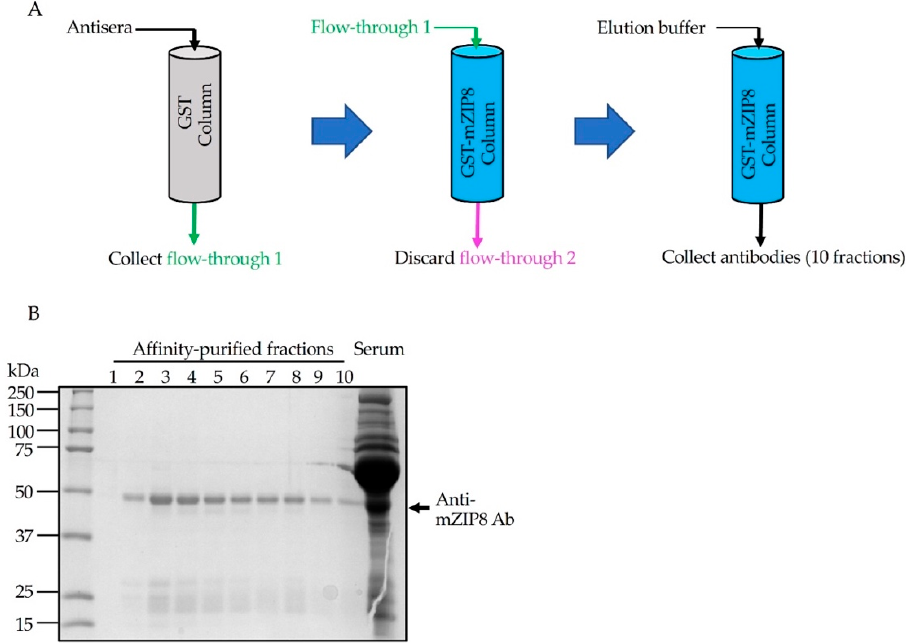
Figure 4. Purification of anti-mZIP8 antibody. ( A ) A schematic illustration of the affinity purification procedure. Rabbit antisera were diluted in binding buffer. The diluted sera were first applied to GST-linked sepharose column (GST column) three times to deplete anti-GST antibodies. The flow-through (flow-through 1) was then applied to the GST–NT-mZIP8-linked sepharose column (GST–mZIP8 column) to allow the binding of anti-mZIP8 antibody. The flow-through (flow-through 2) was discarded and the elution buffer was applied to elute antibodies (10 sequential fractions were collected, 1 mL/fraction). ( B ) Coomassie staining of SDS-PAGE gel loaded with different fractions of anti-mZIP8 antibodies, together with the original antiserum. The pooled antibodies from fractions 2, 3, and 4 were further used for antibody validation experiments.